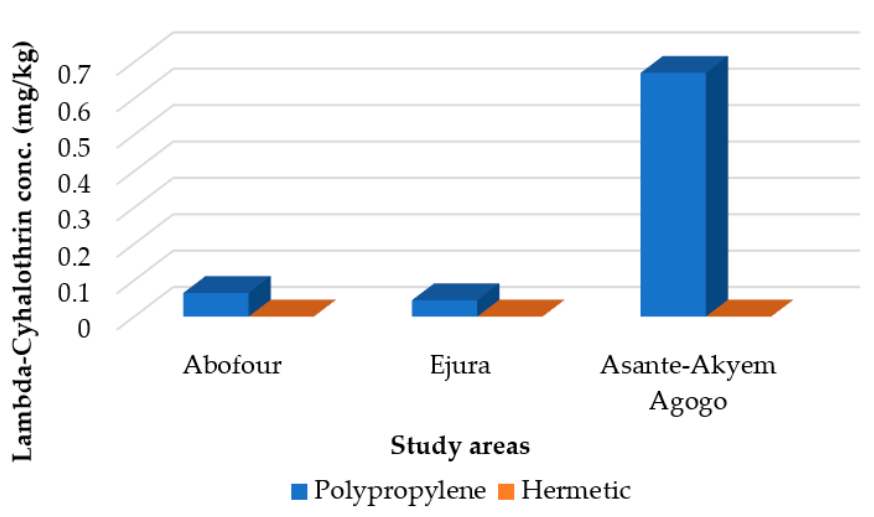
Figure 4. Lambda-cyhalothrin residue in hermetic and polypropylene bags among study locations. Lambda-cyhalothrin was detected in all maize samples stored in polypropylene and all were above the EU maximum residue limit of 0.02 mg/kg. Deltamethrin residues were detected in hermetic bags and were below the EU maximum residue limit of 2.0 mg/kg as reported by Milne [14].